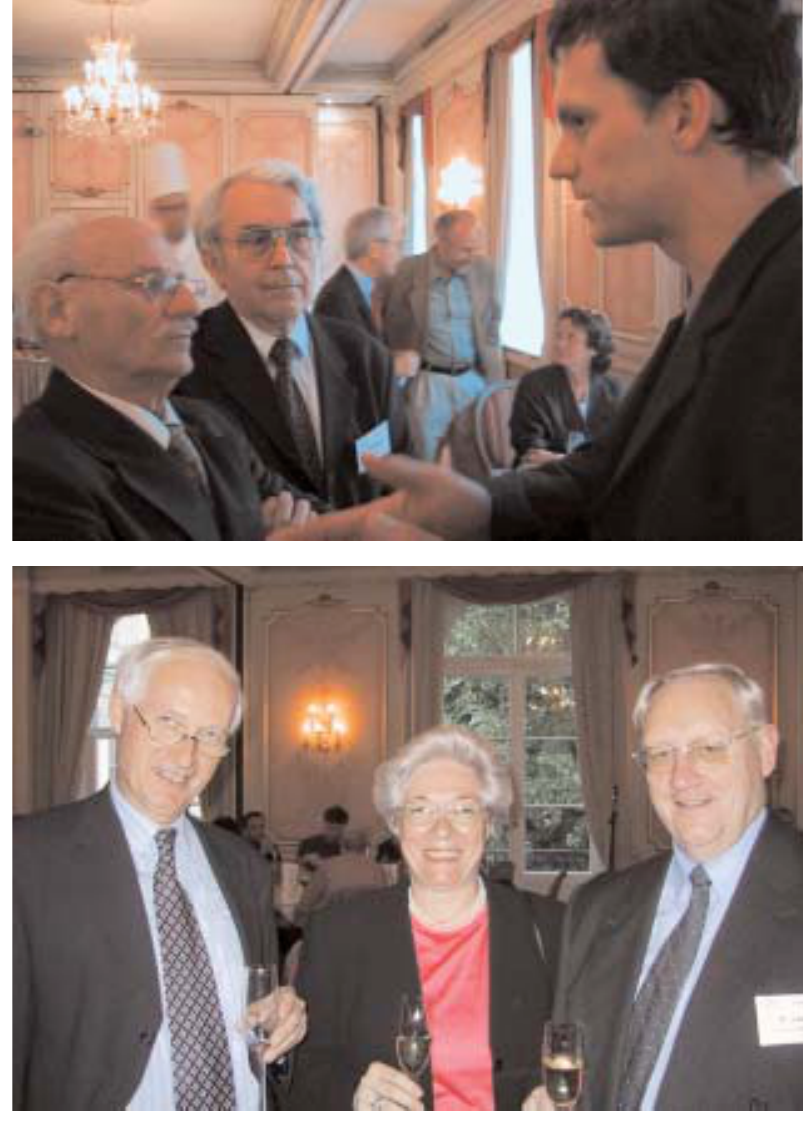
Figure 8 and 9: During the conference